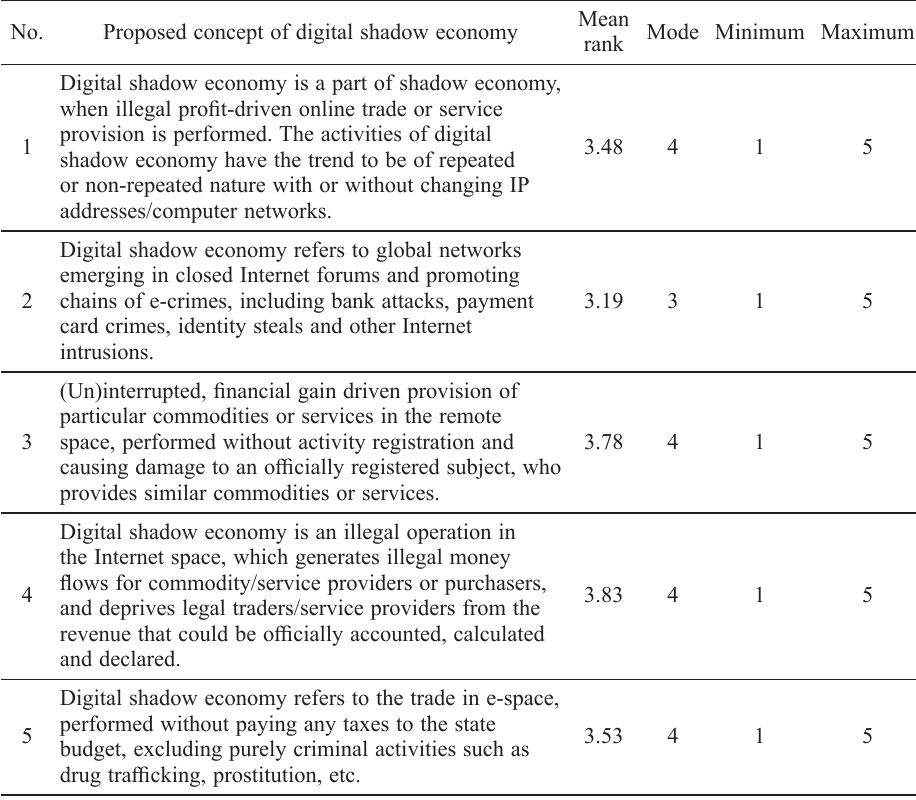
Table 1. Mean ranks for the proposed concepts of digital shadow economy: consumers’ attitude (compiled by the authors with reference to the survey results) No.